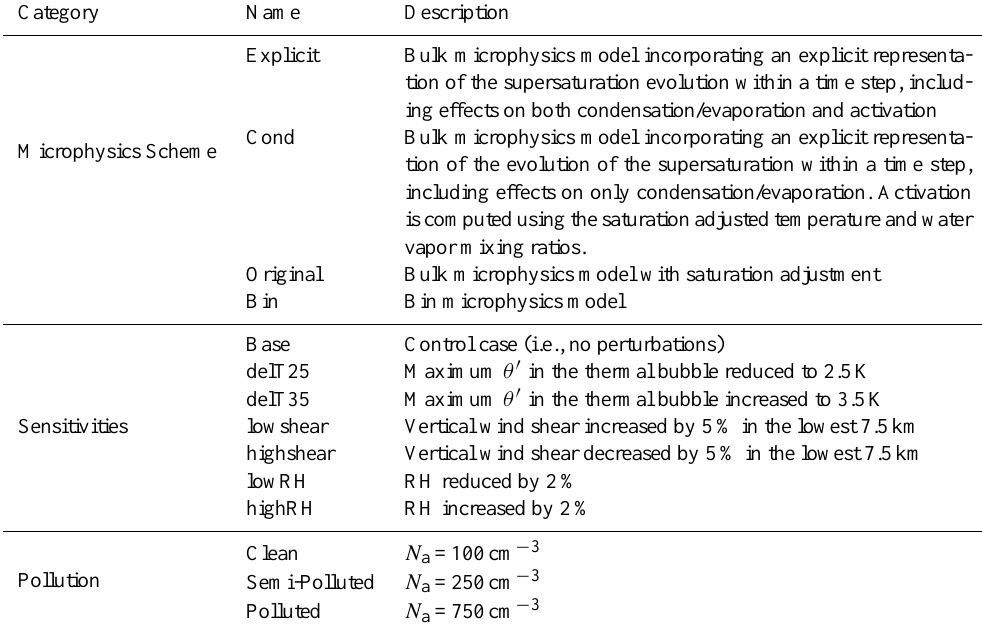
Table 1. Simulation descriptions.